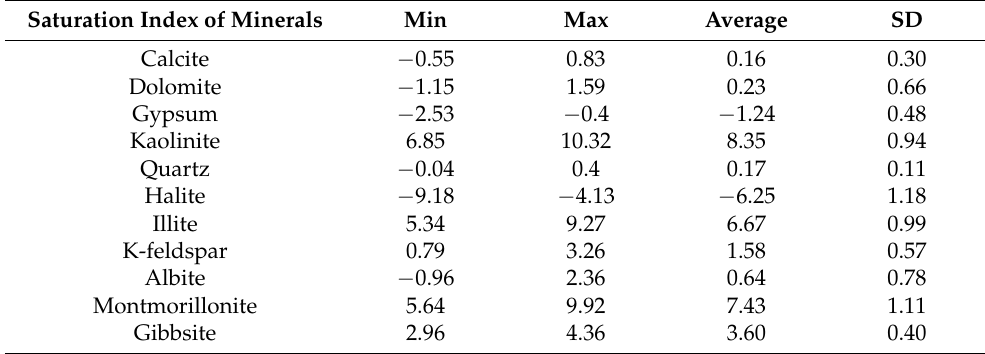
Table 2. Statistical data of saturation index of minerals in groundwater (Min: minimum, Max: maximum, SD: standard deviation).